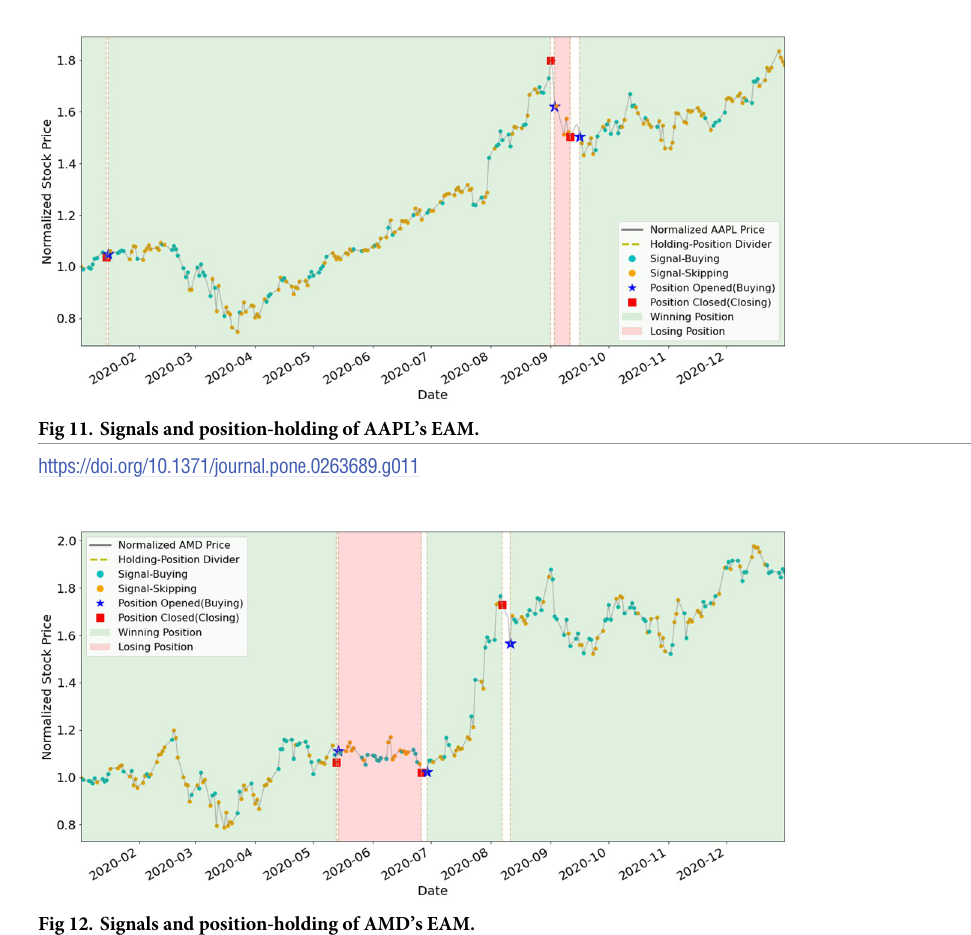
closing prices, we color the period as light green (winning position), otherwise light red. Period of no-position will be left as blank. According to the results illustrated in the figures, the posi- tions are opened and closed at just the right timings by the corresponding EAMs for most assets.